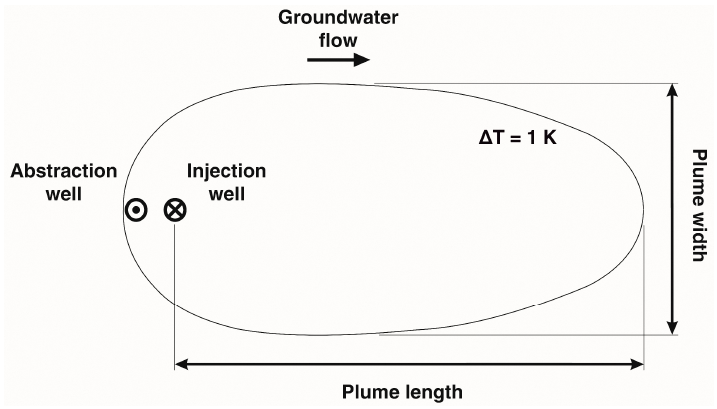
Figure 3. Plume dimensions considered in the sensitivity analysis.